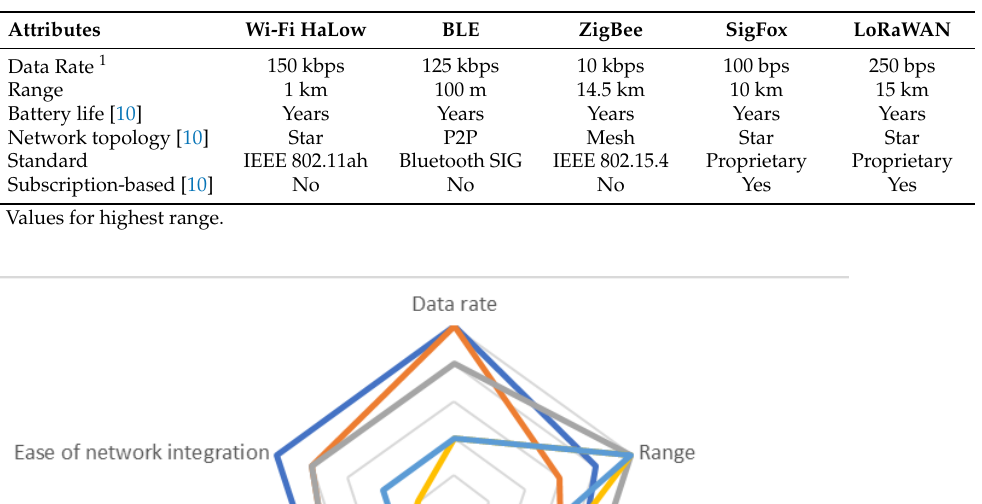
Table 1. Description of wireless communication protocols used for data transmission between sensors and relays.